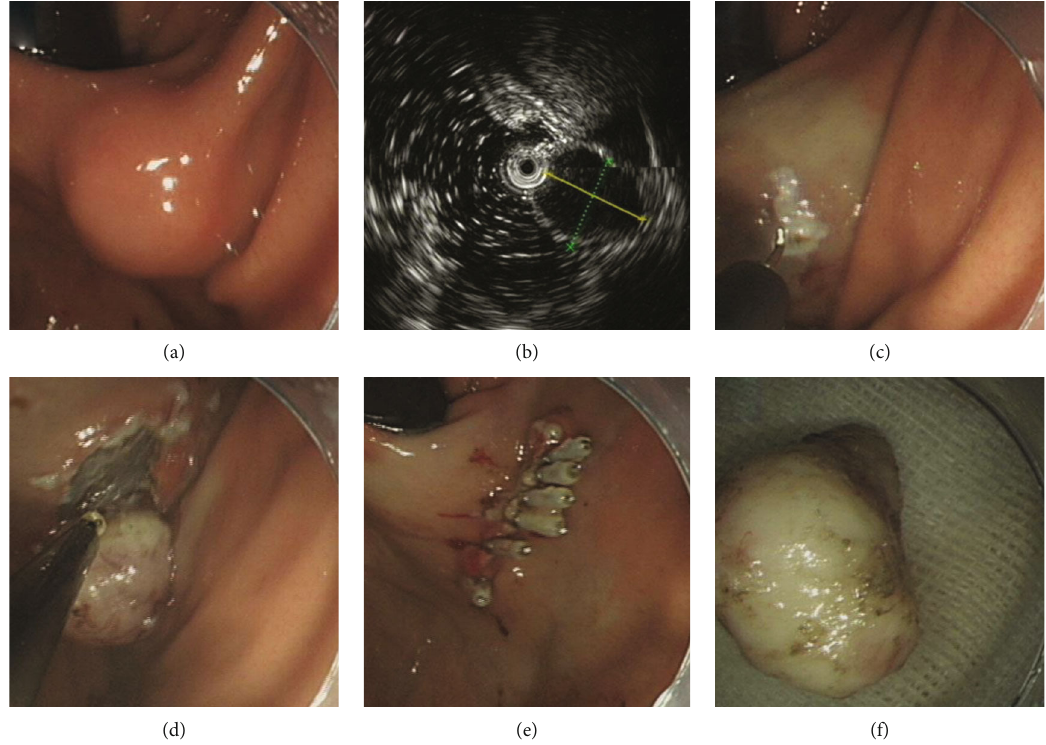
Figure 1: Endoscopic submucosal dissection treatment for a gastric GIST: (a) gastric GIST identi fi ed by endoscopy; (b) the same gastric GIST observed by endoscopic ultrasound; (c) marking outside the tumor; (d) dissection of the tumor; (e) close the wound; (f) the resected tumor. GIST: gastrointestinal stromal